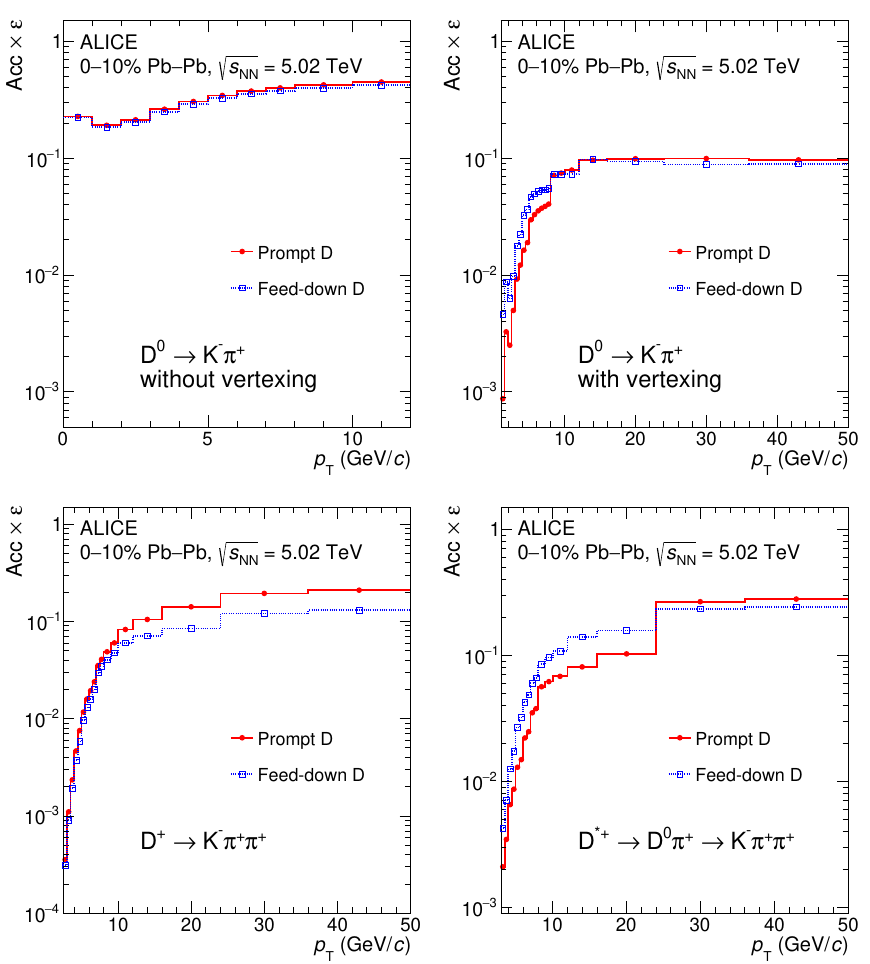
Figure 2 . Product of acceptance and efficiency ( Acc × (cid:15) ) as a function of p T for prompt (red circles) and feed-down (blue squares) D mesons in Pb–Pb collisions for the 0–10% centrality